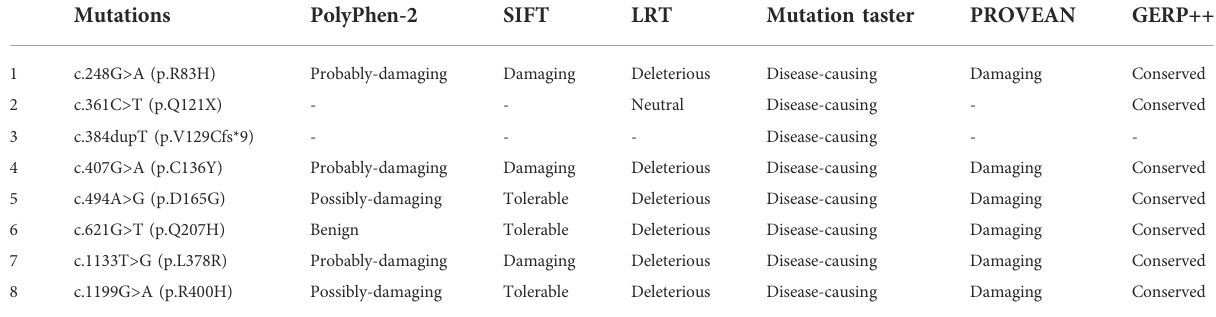
TABLE 3 List of the 8 novel variants and their possible pathogenicity analysis.